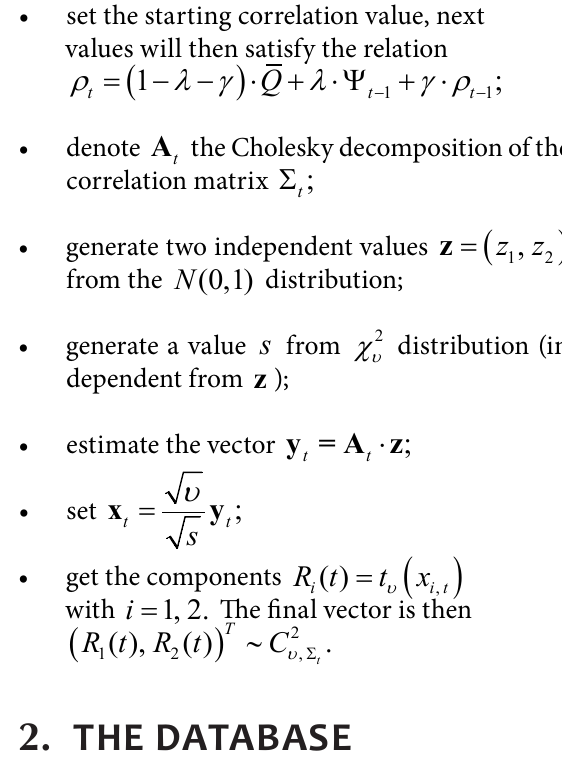
Table 1. Descriptive statistics: MIB, oil, gas, coal and associated returns Indicator Standard